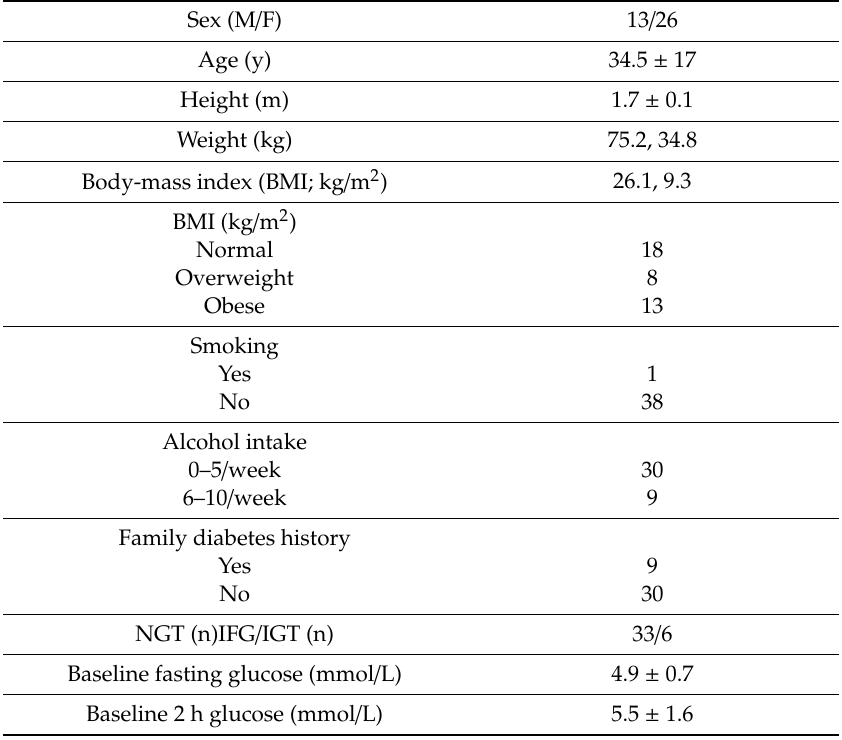
Table 1. Baseline characteristics of participants 1 .